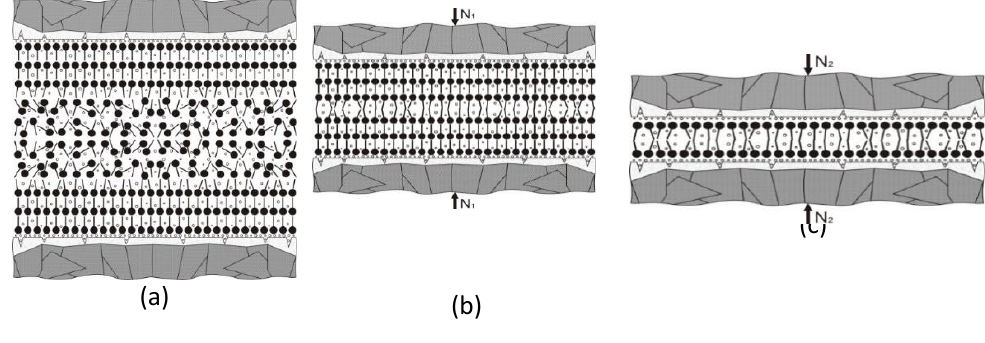
Fig. 3. Schemes of the structure of Epitropic-Liquid-Crystalline oil layers, taking into account active molecules adsorbed on the surfaces (plates with circles) and gases dissolved in oil (transparent circles) between two surfaces with a gap (a); layer-by-layer desorption of supra-monomolecular layers during their static compression by force N1 (b); as well as a diagram of the uniaxial stress state of monomolecular layers adsorbed on friction surfaces at higher compression loads N2 >> N1 (c)